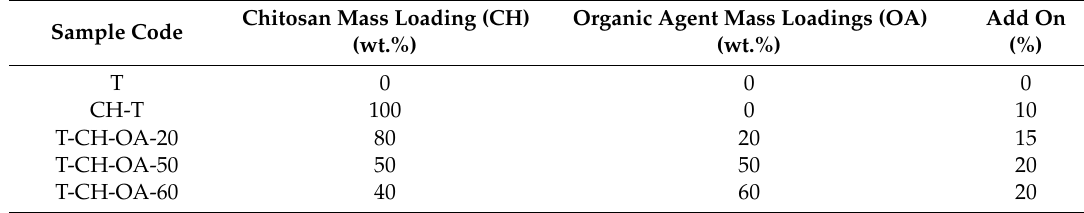
Table 1. Composition of developed coating